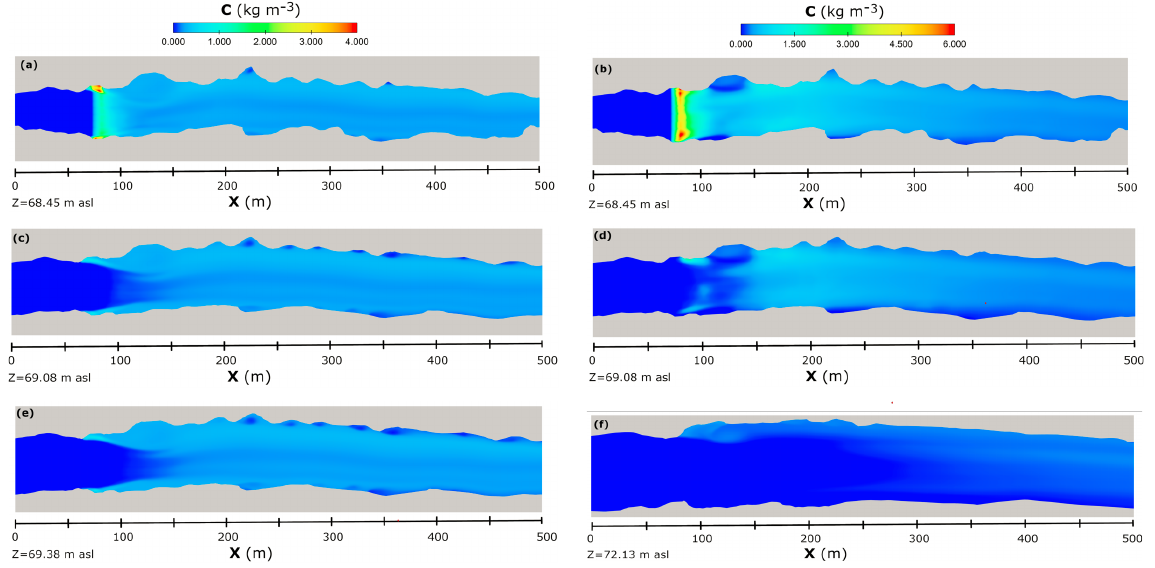
Figure 8: Spatial distribution of chloride for low flow 41 m 3 s -1 at elevation (a) 68.45, (c) 69.08, (e) 69.38 m asl and for high flow 318 m 3 s -1 at elevation (b) 68.45, (d) 69.08, (f) 72.13 m asl.